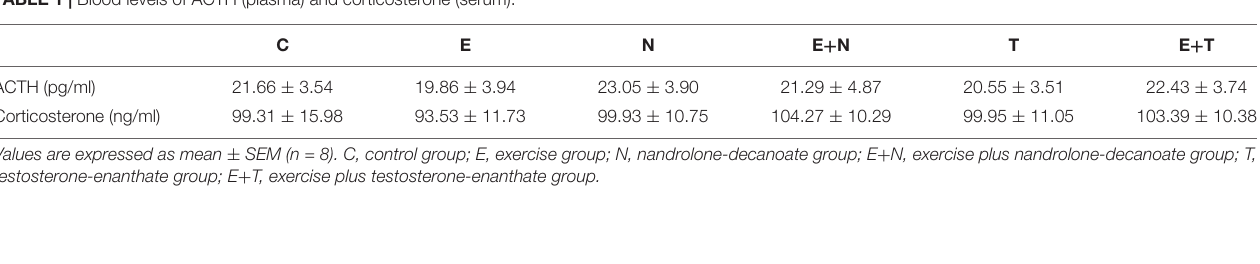
TABLE 1 | Blood levels of ACTH (plasma) and corticosterone